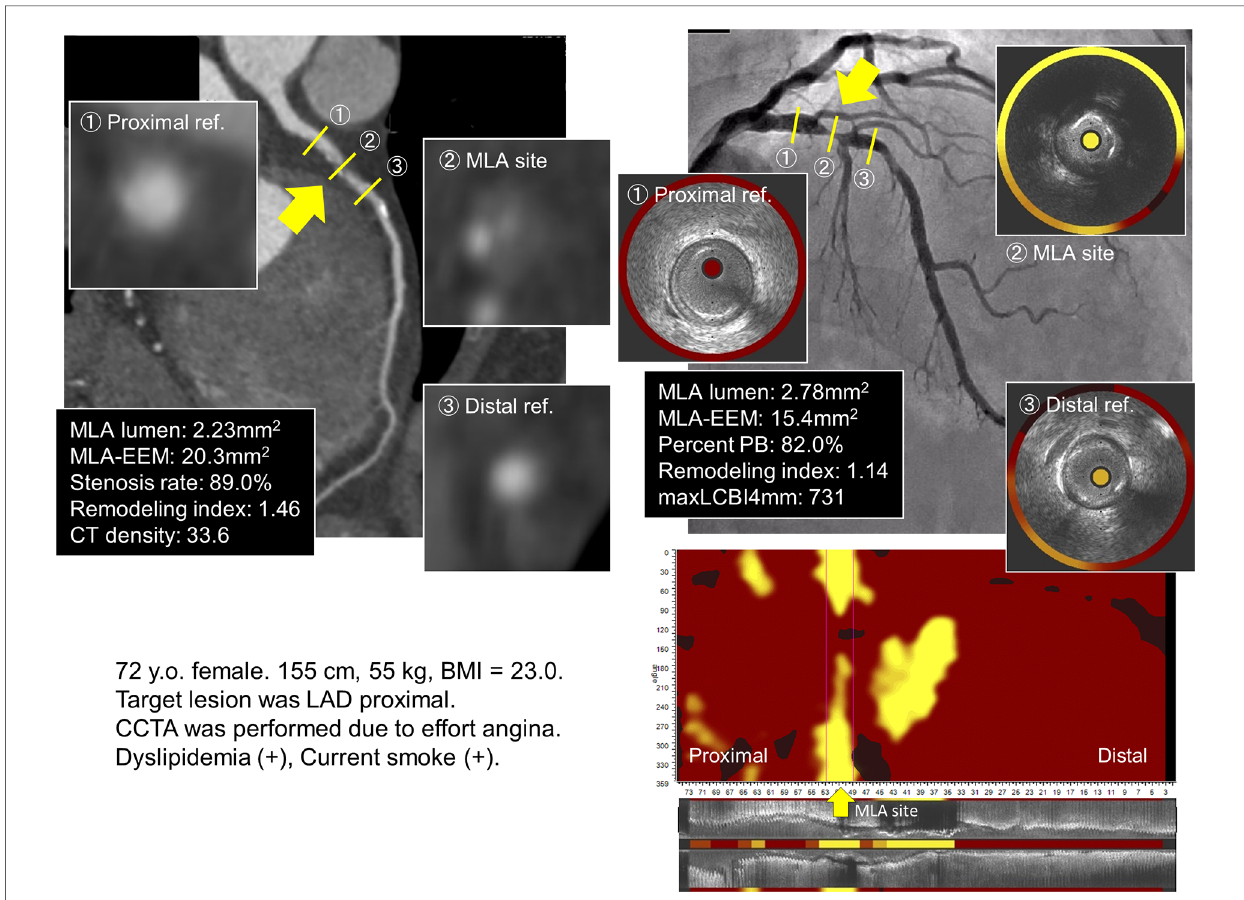
FIGURE 1 Coronary angiography, CCTA, gray-scale IVUS, and NIRS for the lipid-rich plaque group. The culprit lesion is located at the proximal LAD. CCTA revealed low CT density with positive remodeling; similarly, NIRS – IVUS showed high maxLCBI4mm with positive remodeling in the culprit segment. (The yellow arrow indicates the site of the minimal lumen area.) The cTnT level increased from 0.002 ng/ml to 0.124 ng/ml after PCI. CCTA, coronary computed tomography angiography; IVUS, intravascular ultrasound; NIRS, near-infrared spectroscopy; LAD, left anterior descending; maxLCBI4mm, maximum value of the lipid-core burden index for any 4-mm segment; cTnT, cardiac troponin T; PCI, percutaneous coronary